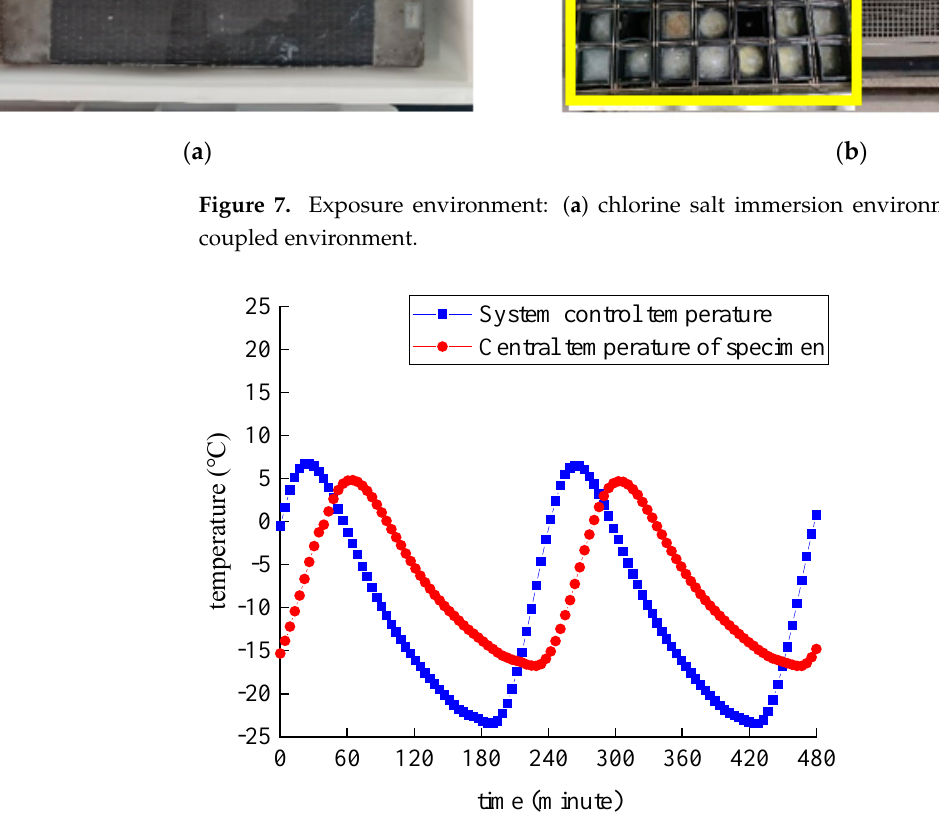
Figure 8. Temperature curve.